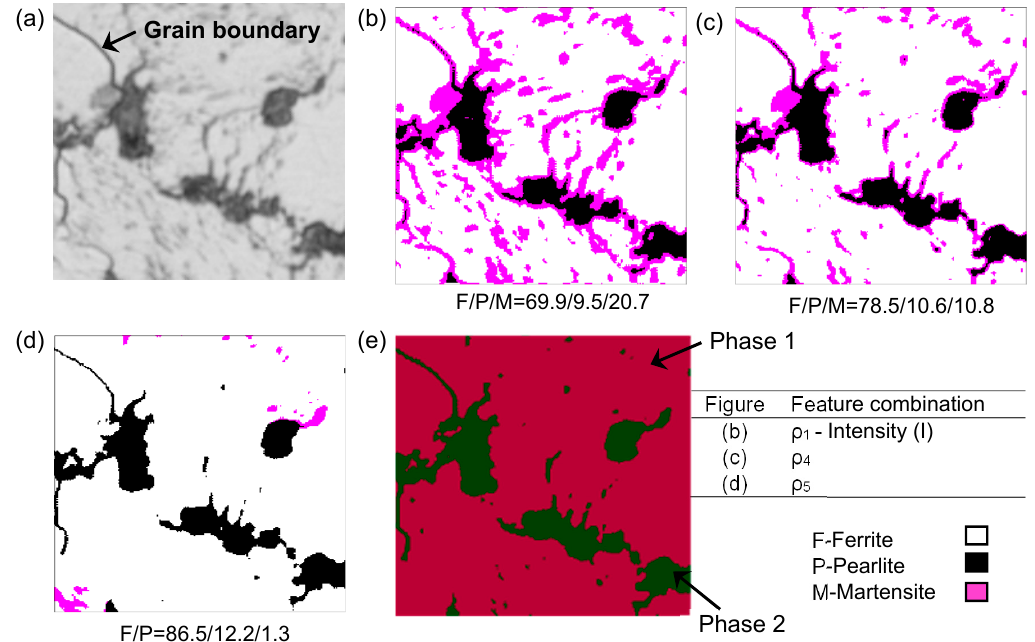
Figure 5. A numerical example illustrating the importance selecting the most relevant textural features: ( a ) original image, ( b ) only ‘pixel intensity’, ( c ) ‘pixel intensity’ and top 3 textural features, ( d ) ‘pixel intensity’ and top 4 textural features, and ( e ) segmentation in ImageJ. It is observed from subfigure ( d ) that the accuracy of classifying metallurgical phases has increased with the addition of more relevant textural features.